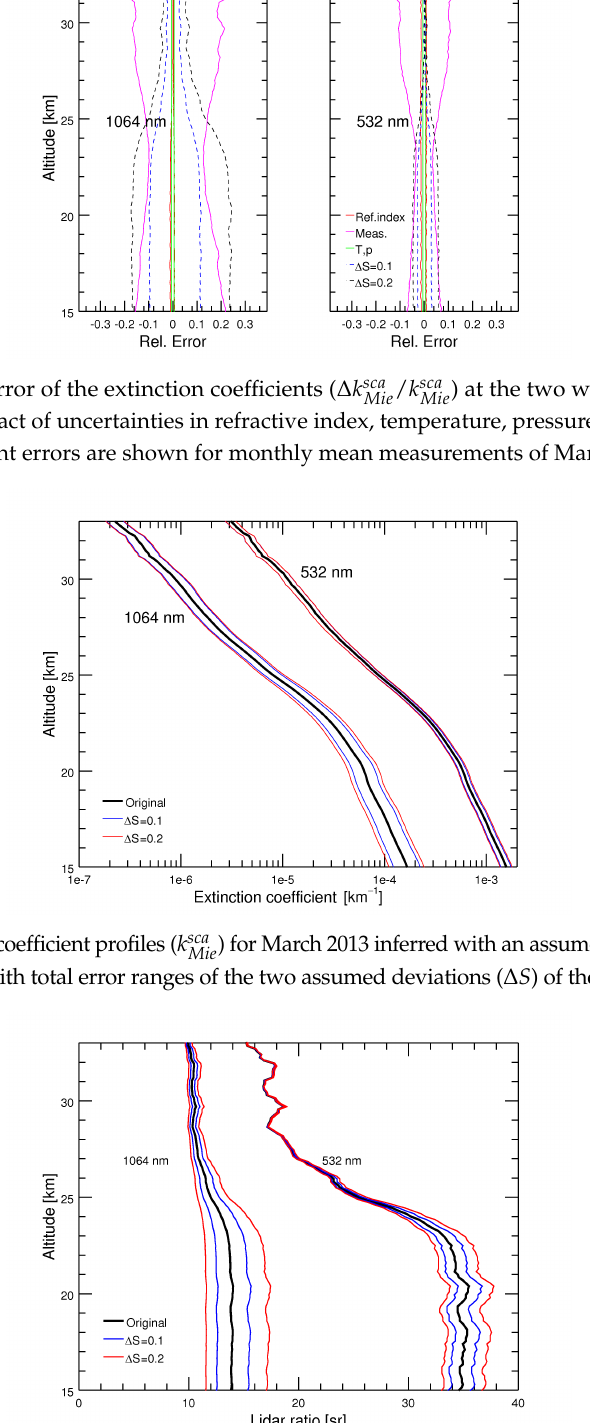
Figure 12. Lidar ratio profiles for March 2013 for an assumed distribution width of S = 1.5 (Original) with total error ranges of the two assumed deviations ∆ S of the distribution